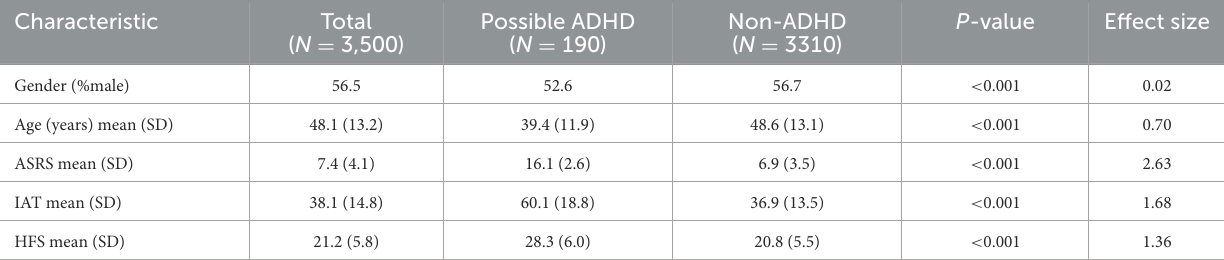
TABLE 1 Descriptive statistics for the entire sample and for the presence/absence of possible ADHD.